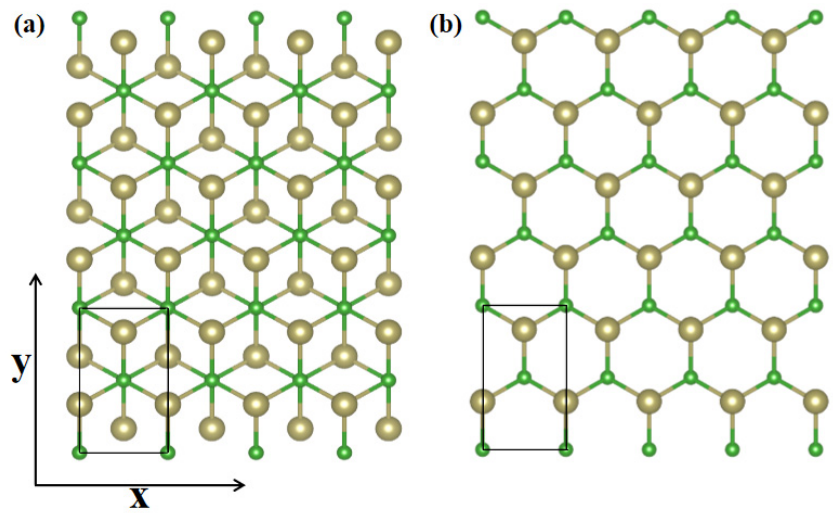
Figure 4. Transformed α -TeB ( a ) and β -TeB ( b ) structures, the x and y directions are shown on the coordinate axes.